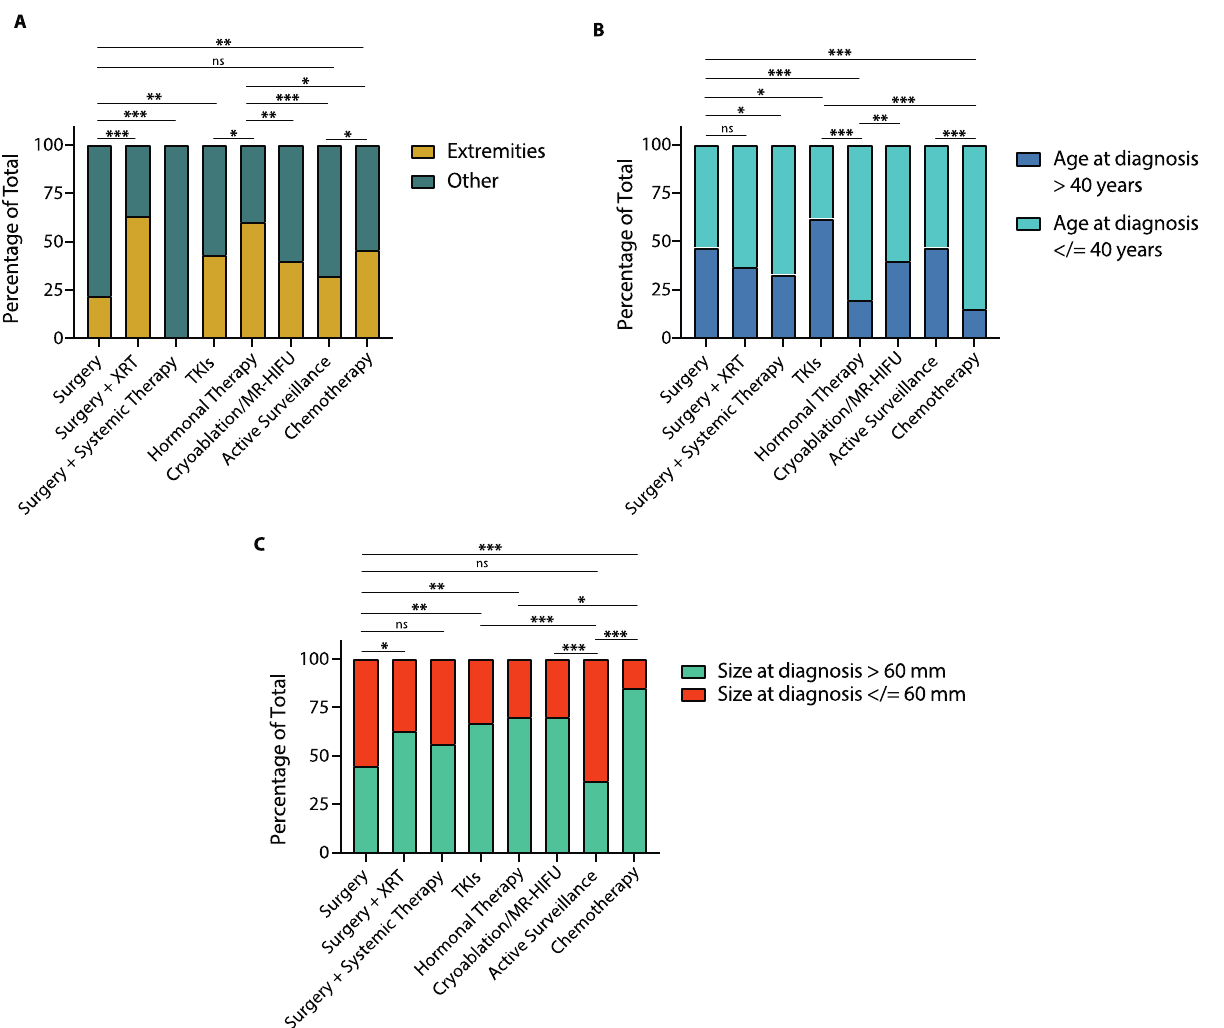
Figure 6. Tumor location, age at diagnosis and tumor size by treatment group in patients with desmoid tumors (DTs). ( A ) Bar graph shows the proportion of patients with DTs of the extremities compared to DTs involving other locations in each treatment group. ( B ) Bar graph shows the proportion of patients older than 40 years and 40 years or younger at diagnosis in each treatment group. ( C ) Bar graph shows the proportion of patients with tumors greater than 60 mm and 60 mm or smaller at diagnosis in each treatment group. XRT: radiotherapy; MR ‐ HIFU: Magnetic resonance ‐ guided high intensity focused ultrasound; TKIs: Tyrosine kinase inhibitors. (* p < 0.05; ** p < 0.01; *** p < 0.001; ns: non ‐ statistically significant, Chi ‐ square test). As far as tumor location, patients who received surgery had a lower proportion of extremity DTs compared to those who received surgery plus adjuvant radiotherapy (22% vs. 63%, p < 0.0001, Figure 6A), cryoablation/MR-HIFU (22% vs. 40%, p = 0.005), TKIs (22% vs. 43%, p = 0.001), hormonal therapy (22% vs. 60%, p < 0.0001), or chemotherapy (22% vs. 46%, p = 0.0003). Patients managed with active surveillance had a similar